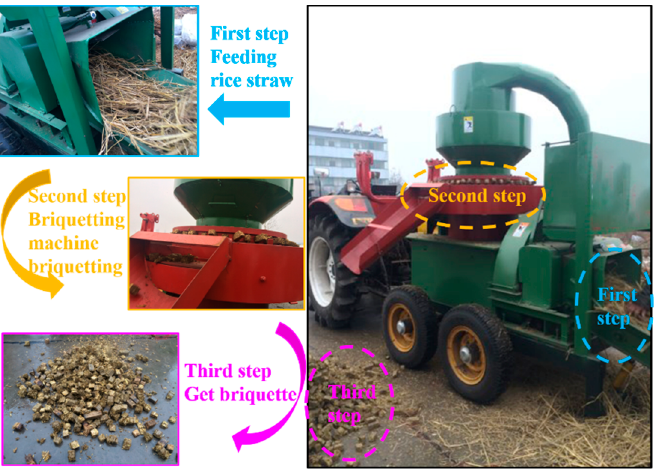
Figure 6. Briquetting test process.